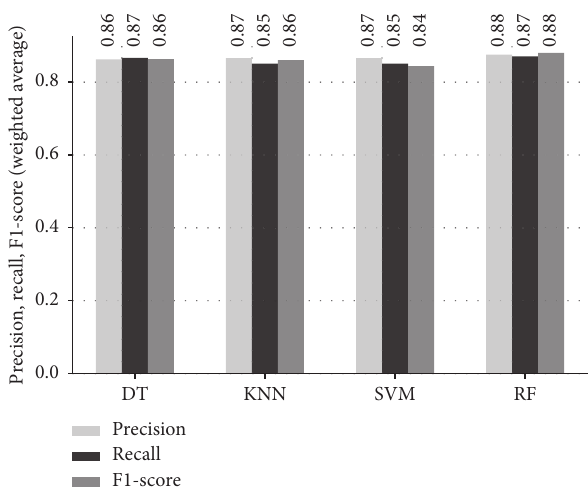
Figure 11: Results for precision, recall, and